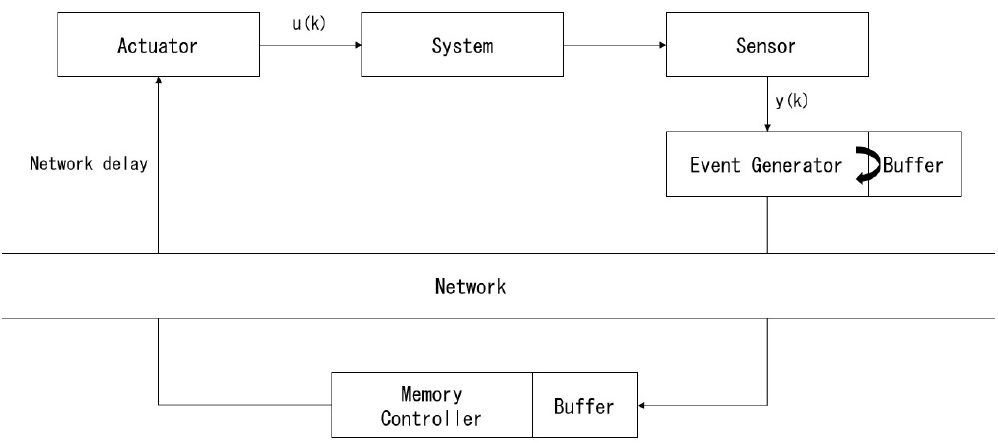
Figure 1. The description of network control systems with memory